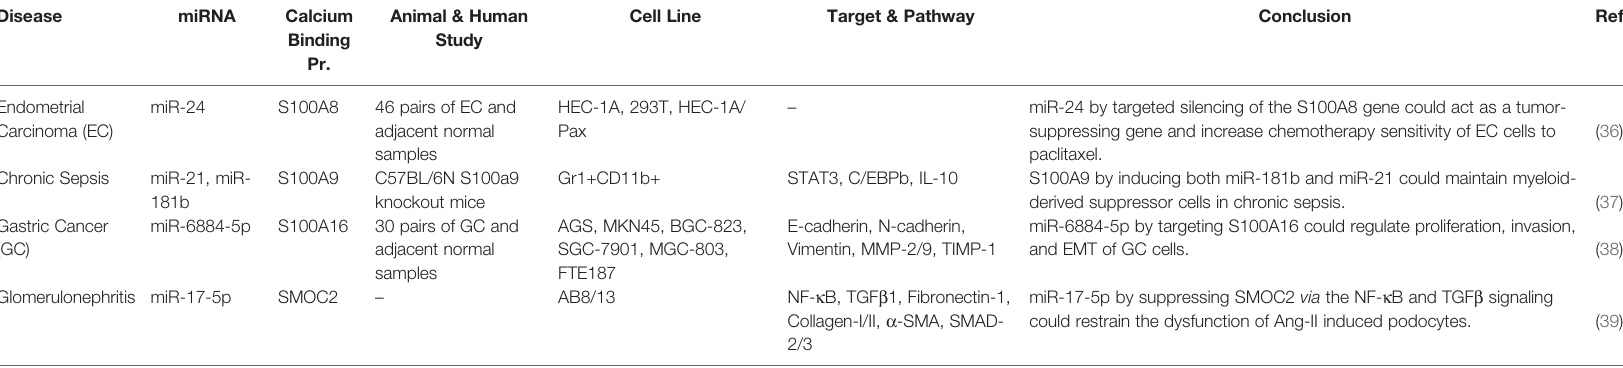
TABLE 8 | miRNAs interacting with other calcium binding proteins.